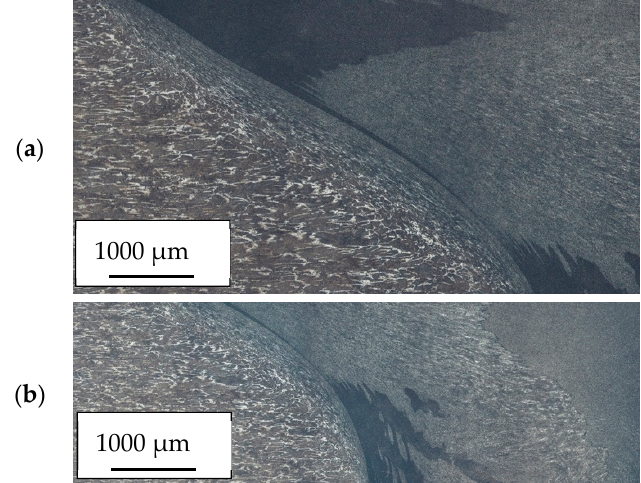
Figure 11. ( a ) Top and ( b ) bottom close-up of the bracket weld in the advancing side.